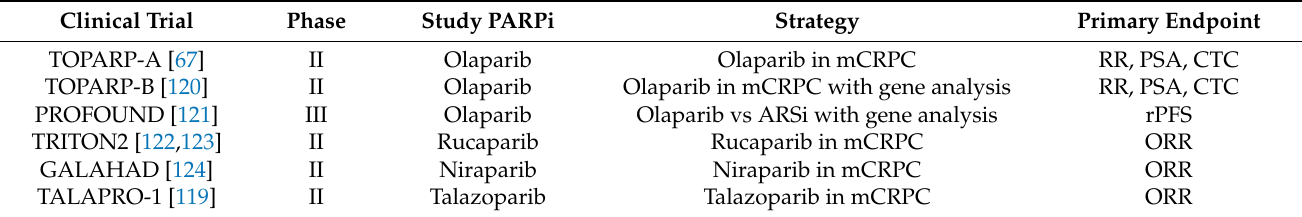
Table 2. Clinical trials of poly(ADP-ribose) polymerase